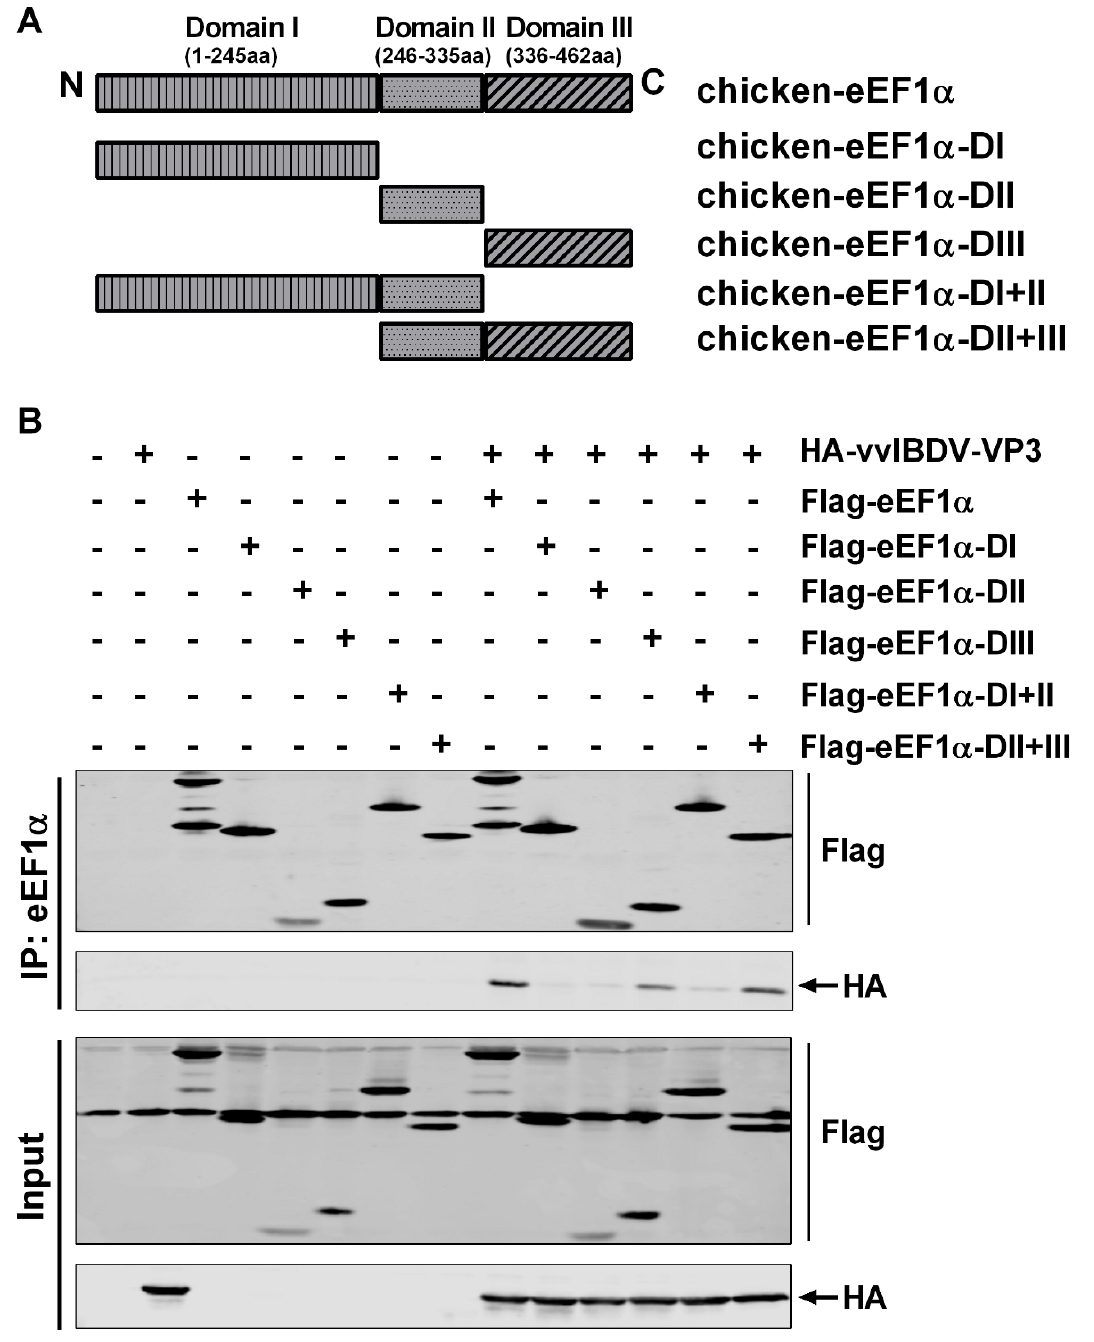
Figure 5. The third domain of cheEF1α interacted with vvIBDV VP3. ( A ) The expression plasmids harboring different domains of cheEF1α were depicted as cheEF1α-DI, cheEF1α-DII, cheEF1α-DIII, cheEF1α-DI+II, and cheEF1α-DII+III. ( B ) 293T cells were transfected expression plasmids with HA-vvIBDV VP3 and Flag-cheEF1α, HA-vvIBDV VP3 and Flag-cheEF1α-DI, HA-vvIBDV VP3 and Flag-cheEF1α-DII, HA-vvIBDV VP3 and Flag-cheEF1α-DIII, HA-vvIBDV VP3 and Flag-cheEF1α-DI+II, or HA-vvIBDV VP3 and Flag-cheEF1α-DII+III. Cell lysates were prepared at 36 hours post transfection and immunoprecipitated with anti-Flag antibody and immunoblotted with anti-Flag or anti-HA antibodies. Each co-immunoprecipitation experiment was repeated three times.